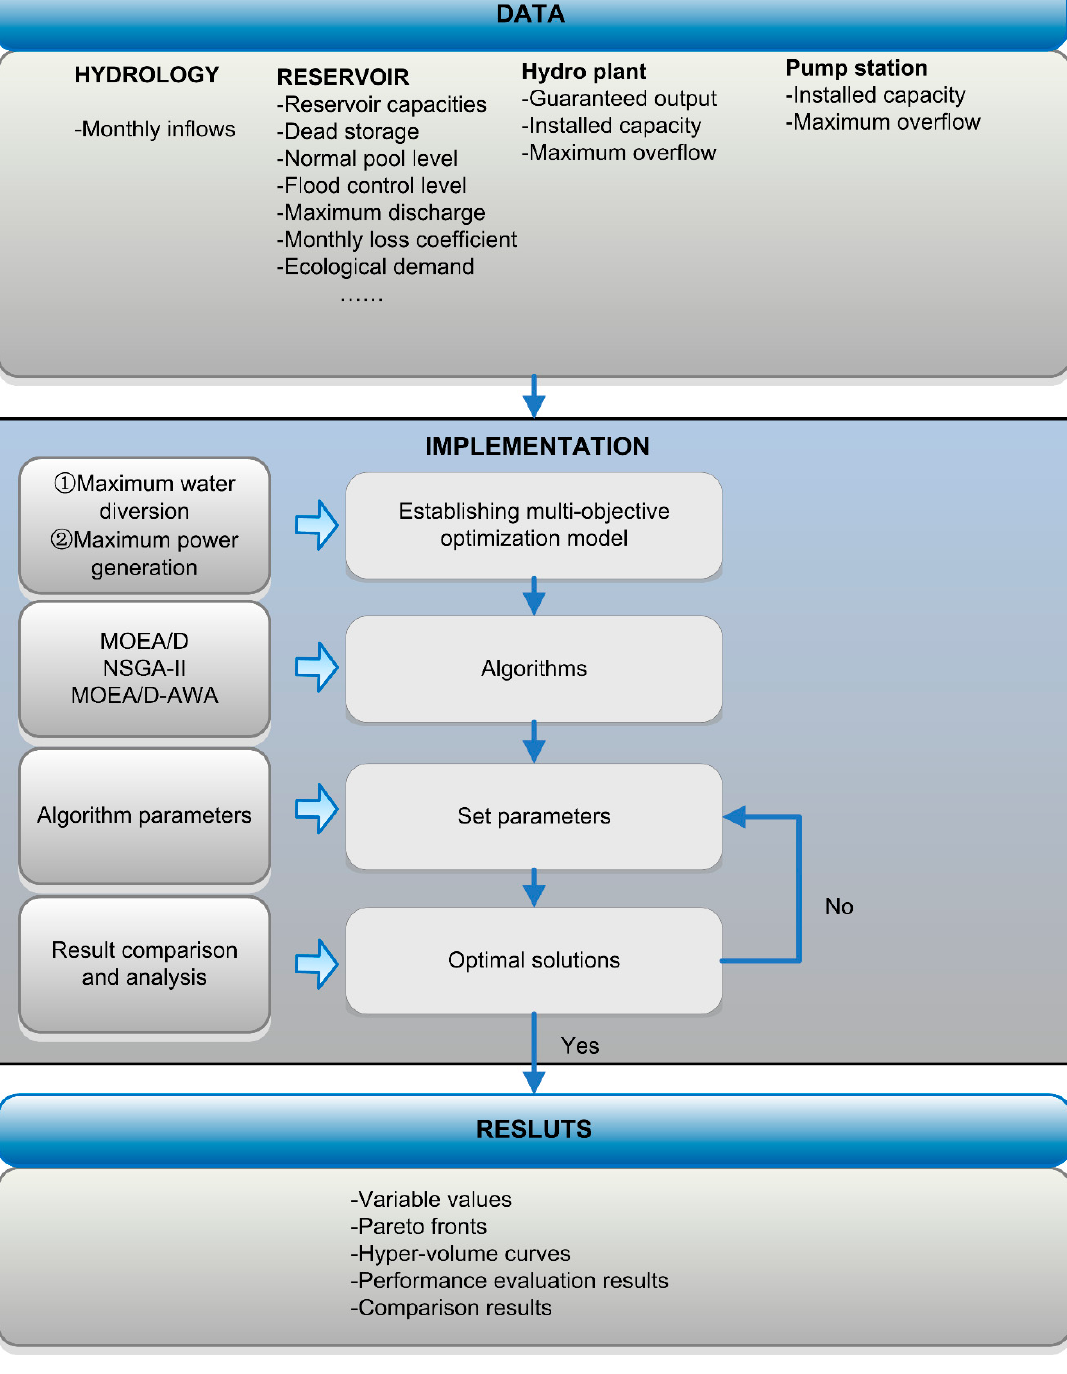
Figure 3. Model and algorithm application.